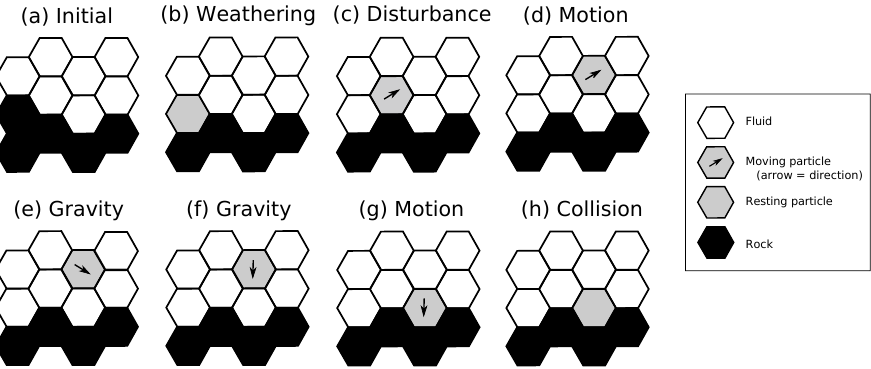
Figure 3. Hypothetical time sequence of transition events (a–h) , illustrating several of the states and transitions in the Grain Hill model. Note that although this example shows a single particle in motion, it is possible for multiple cells to exist in a state of motion at any given